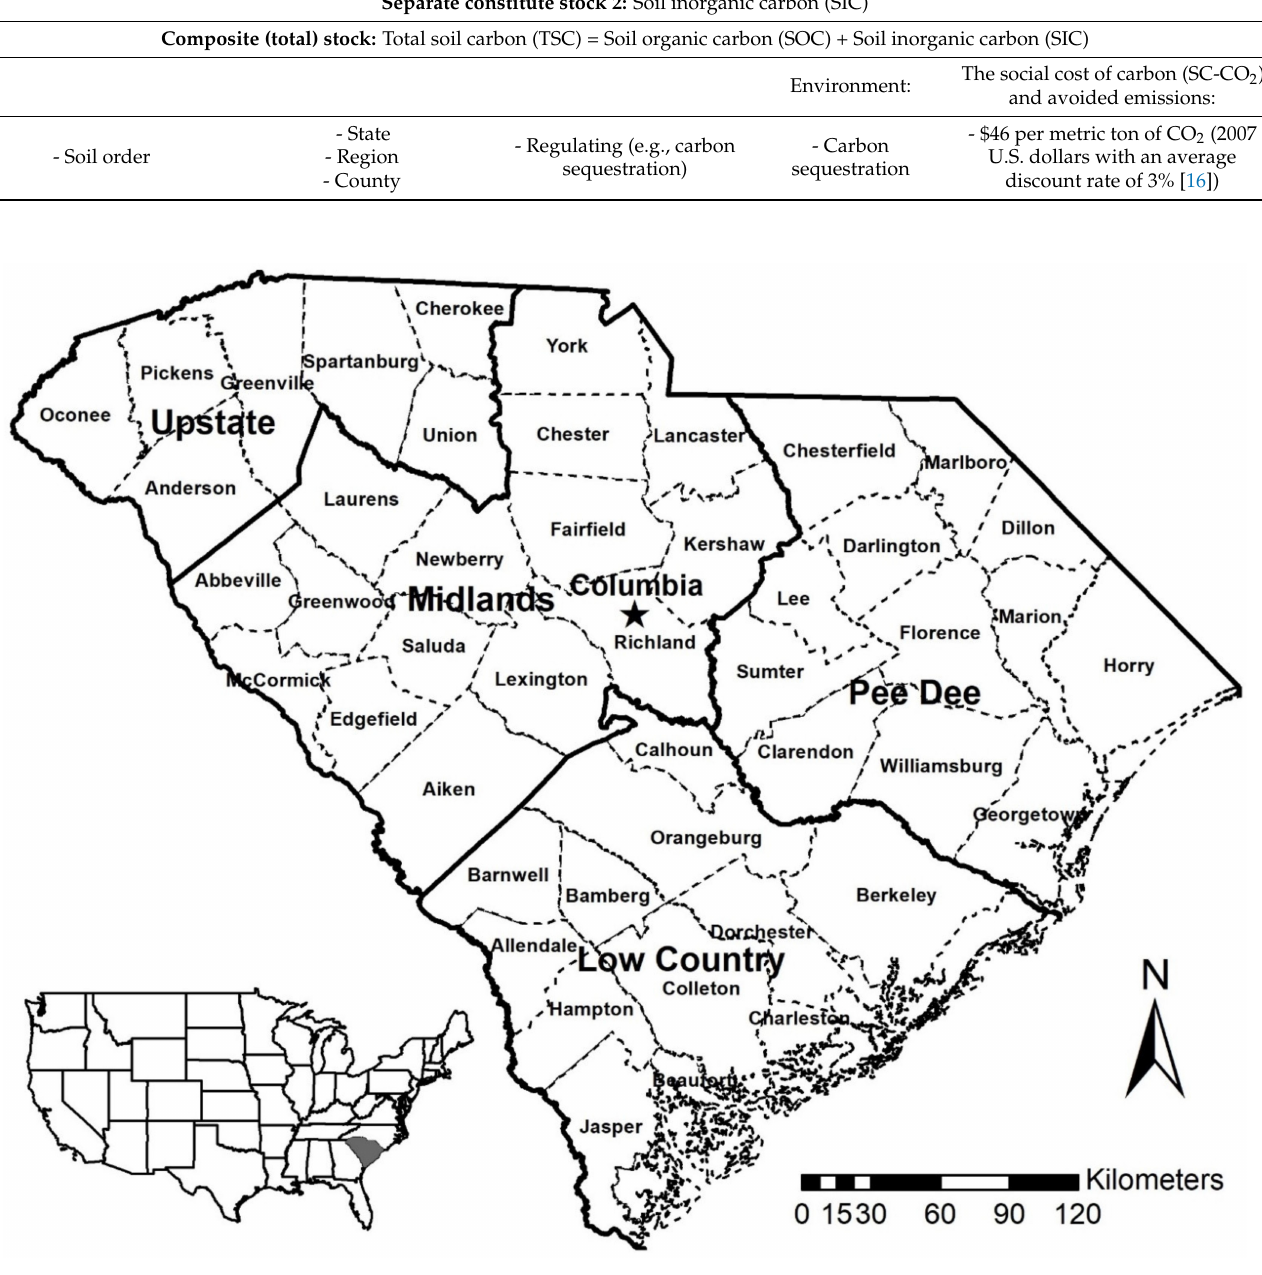
Figure 2. Administrative map of South Carolina (U.S.A.) (33.8361 ◦ N, 81.1637 ◦ W) with 46 counties and four regions